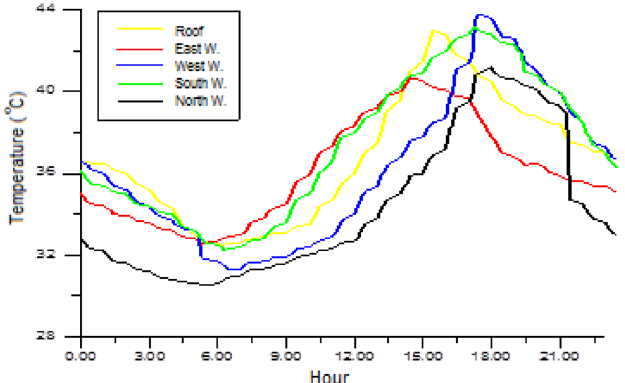
Fig. 5. Internal surface temperature in the ef fi cient